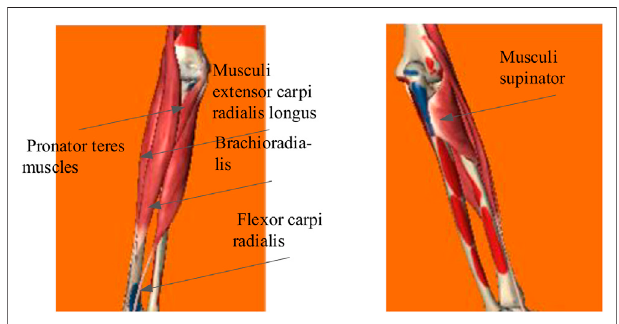
FIGURE 2 | Selected muscle lateral freedom of the forearm